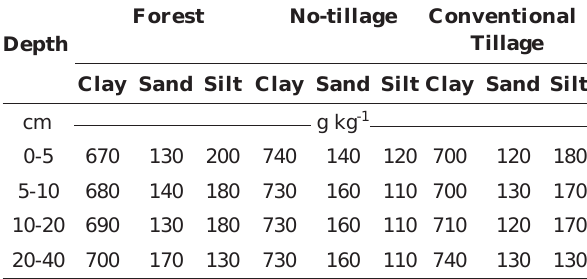
Table 1. Results of granulometric analysis under the two management systems and native forest at four soil